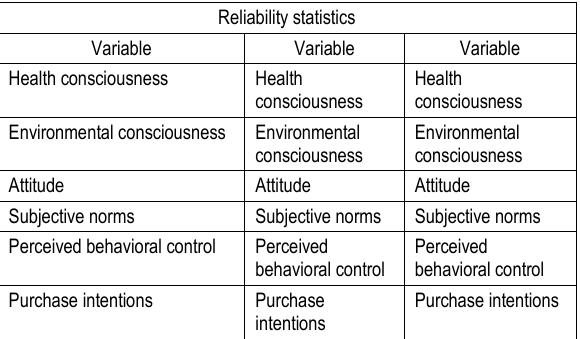
Table 1. Reliability for each